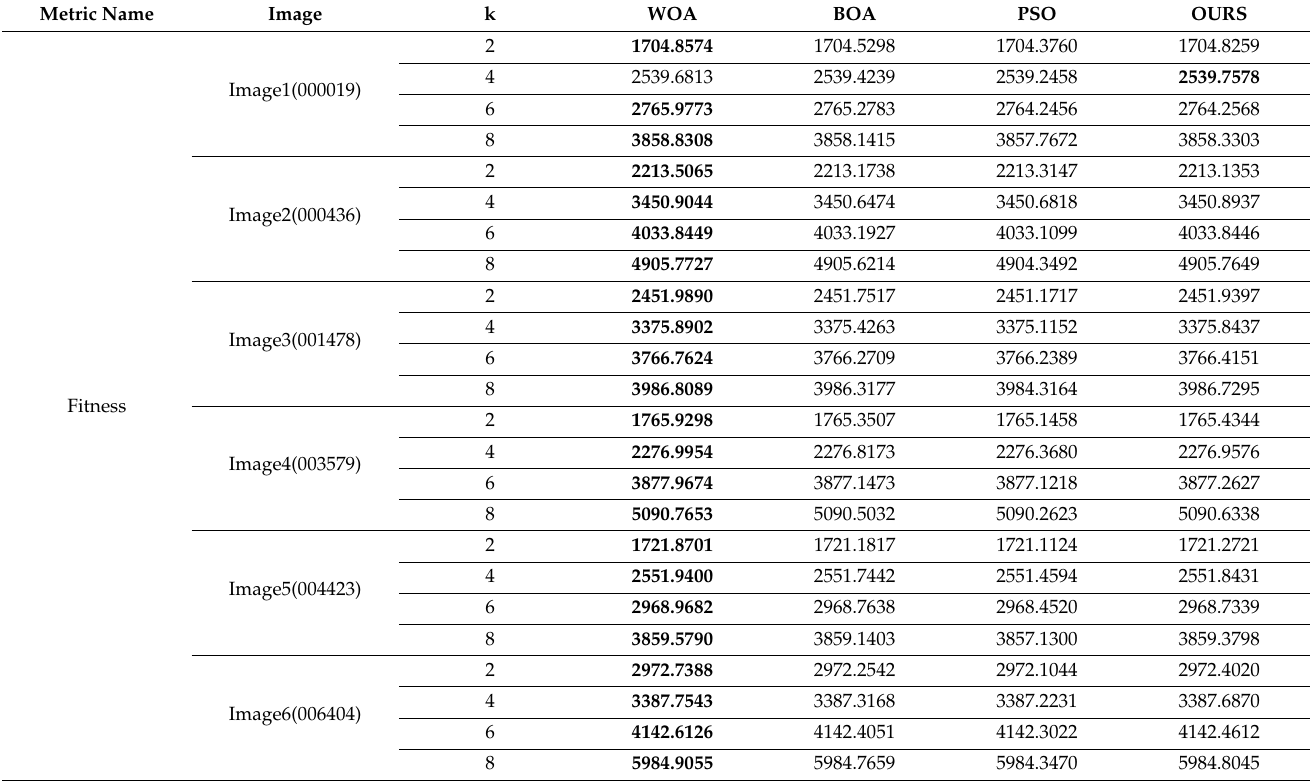
Table 6. Comparison of Fitness in images